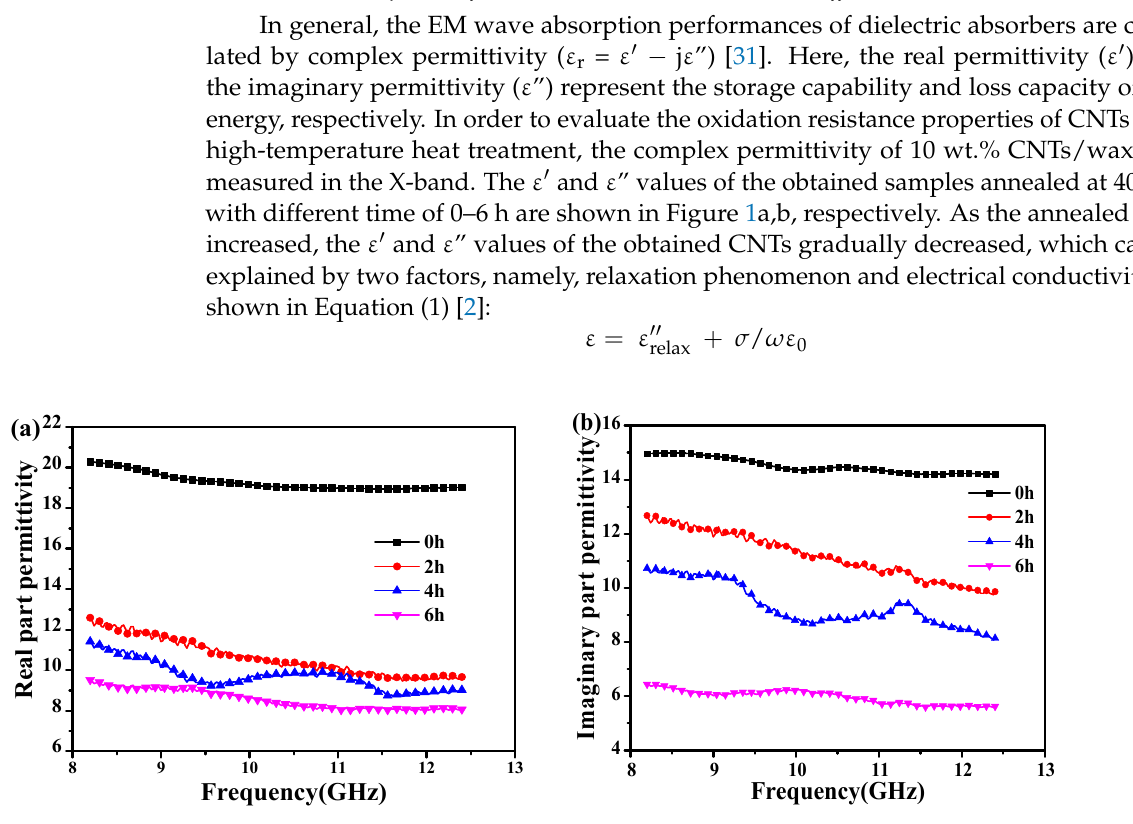
Figure 1. The ( a ) real and ( b ) imaginary part of complex permittivity of CNTs, annealed at 400 °C, with 0–6 h.